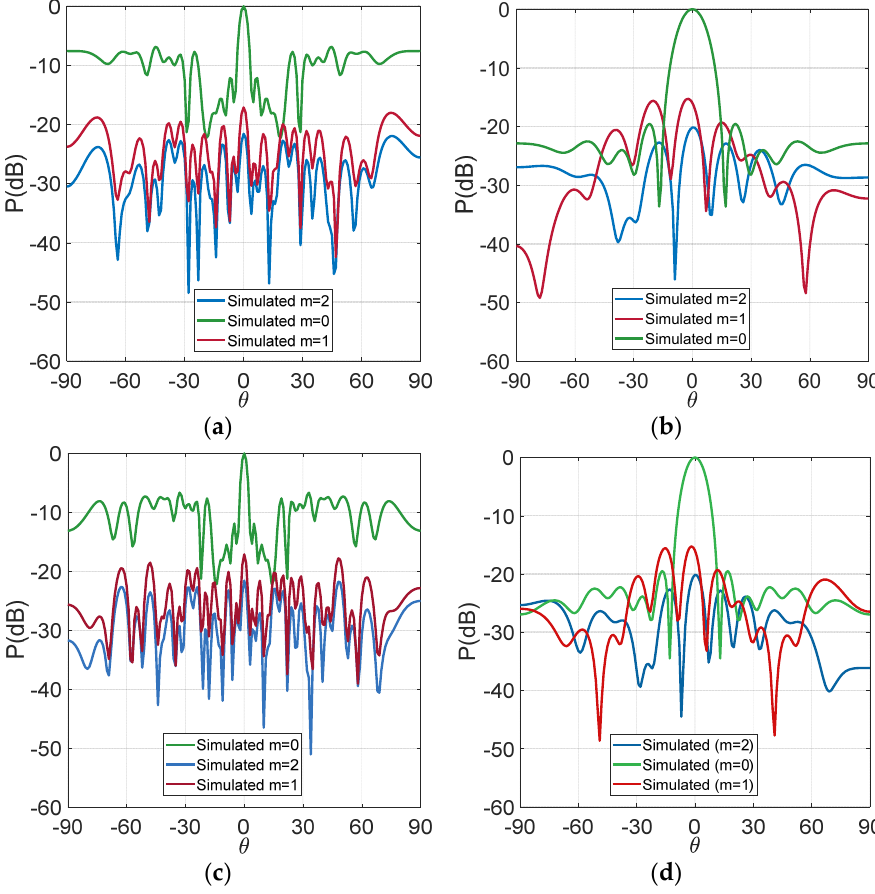
Figure 4. Simulated patterns: ( a ) non ‐ uniform TMA at 3.4 GHz; ( b ) uniform TMA at 3.4 GHz; ( c ) non ‐ uniform TMA at 4.4 GHz; ( d ) non ‐ uniform TMA at 4.4 GHz.